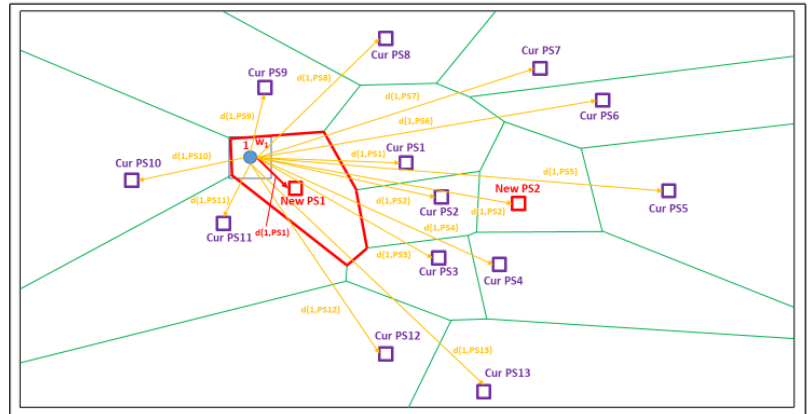
Figure 17. Example of computing the Fitness function.